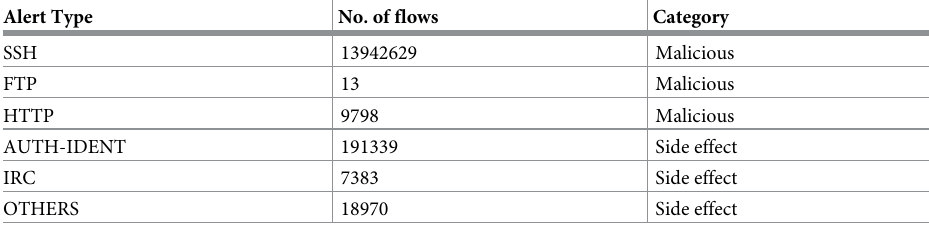
Table 2. Detailed flows in Sperotto’s dataset.